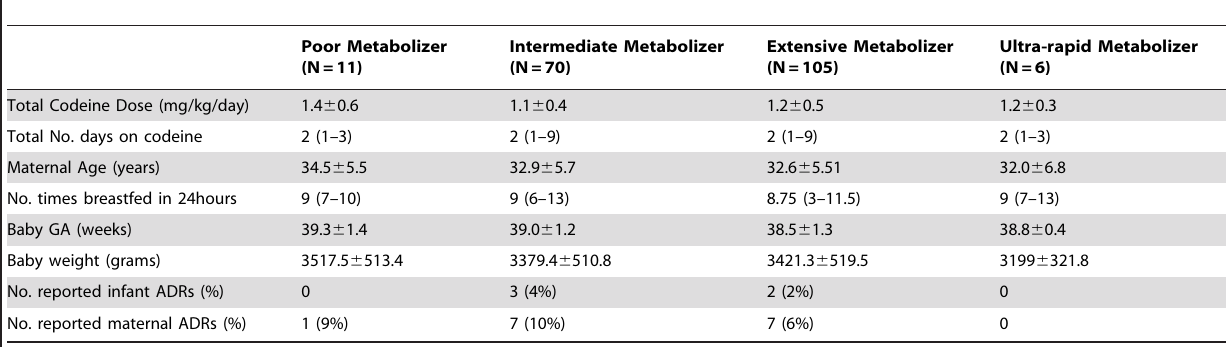
Table 2. The influence of CYP 2D6 genetic factors and breakdown of